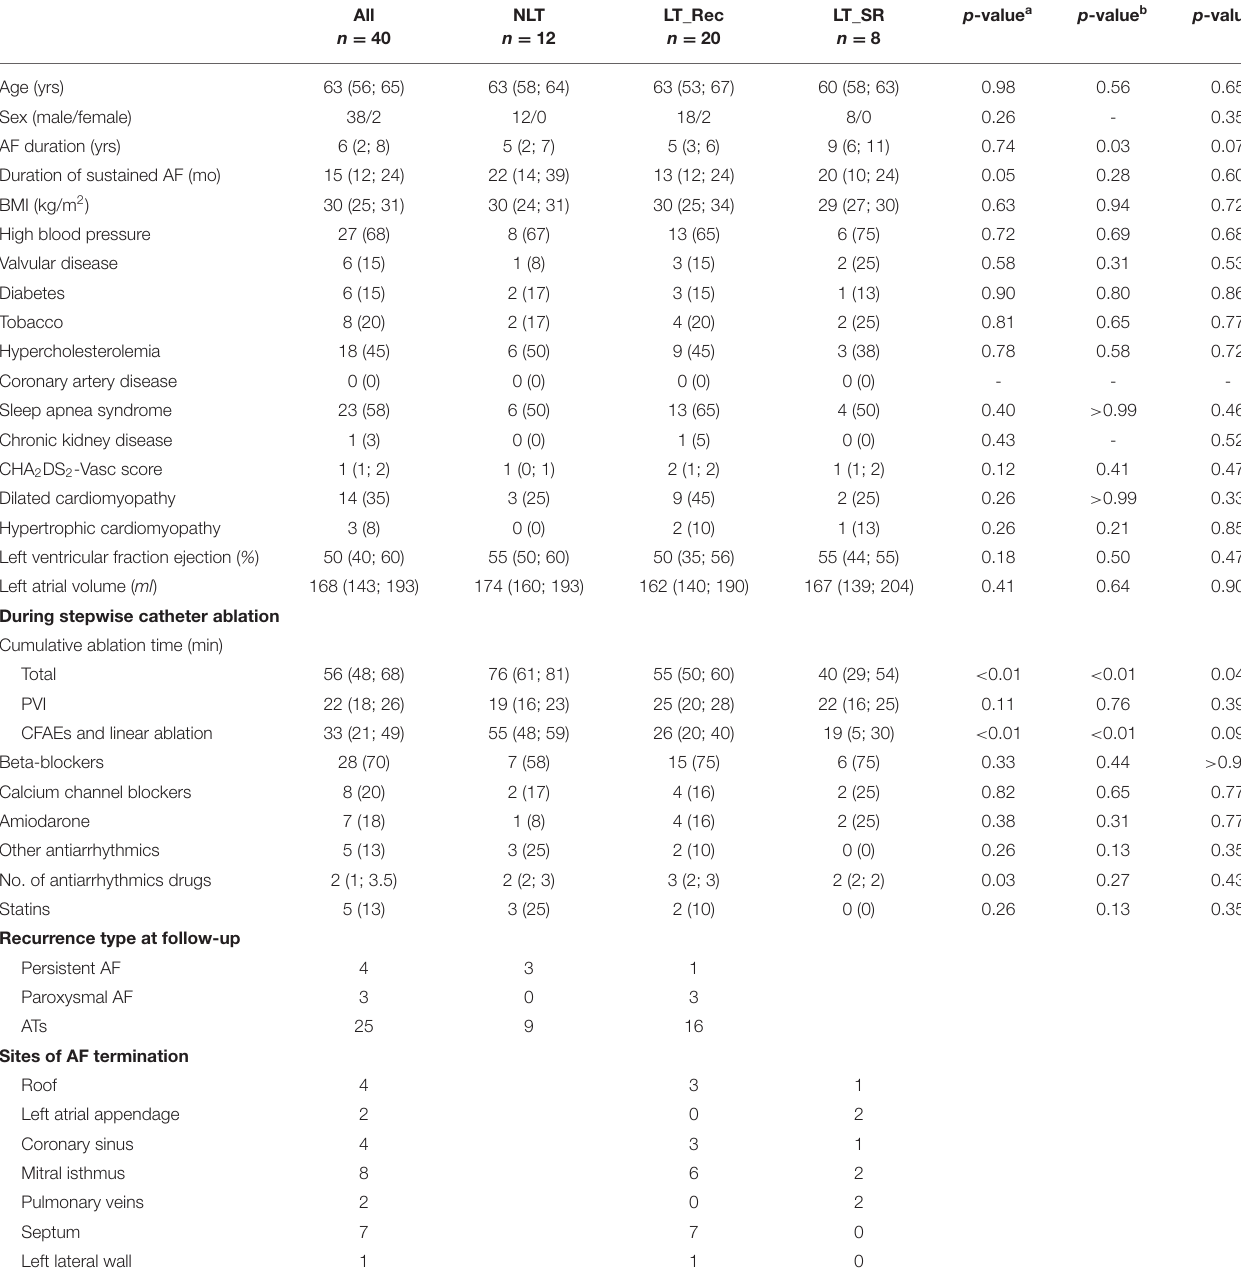
TABLE 1 | Clinical